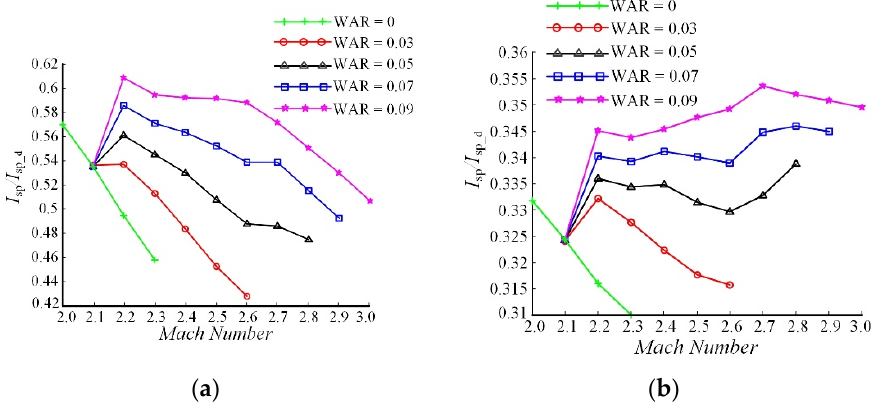
Figure 19. The specific impulse variation of the WIPCC engine ( a ) without afterburning, ( b ) with afterburning.